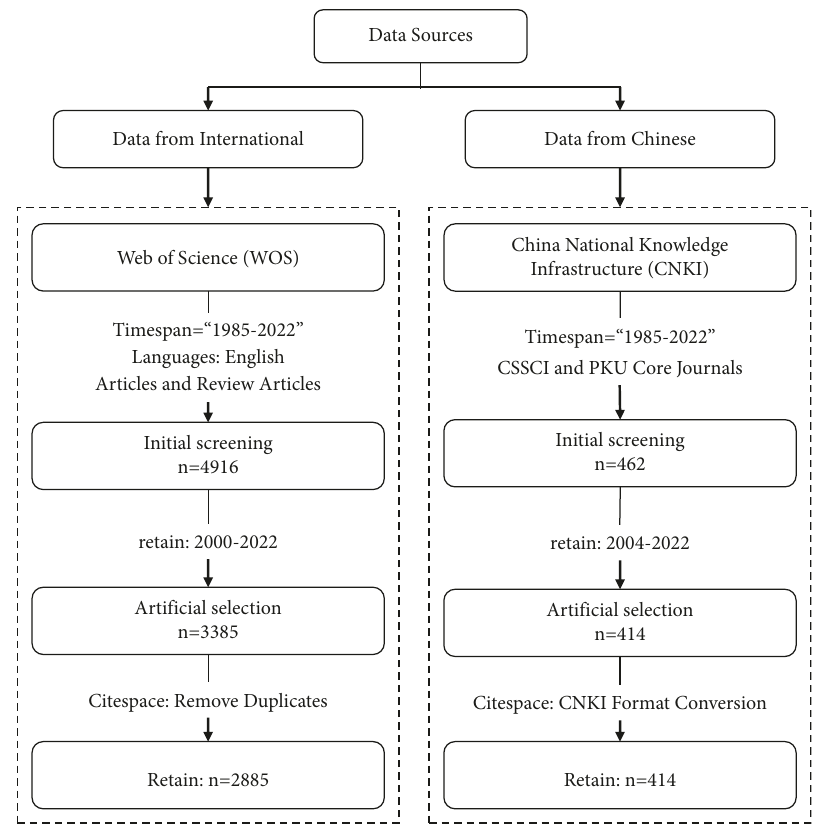
Figure 1: Paper retrieval procedure.